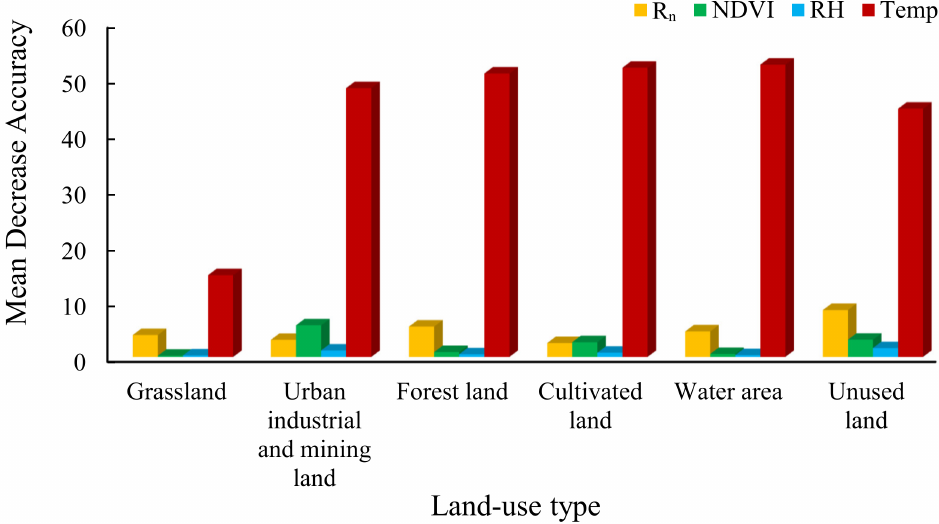
Figure 8. Effects of meteorological factors on the evapotranspiration of different land-use